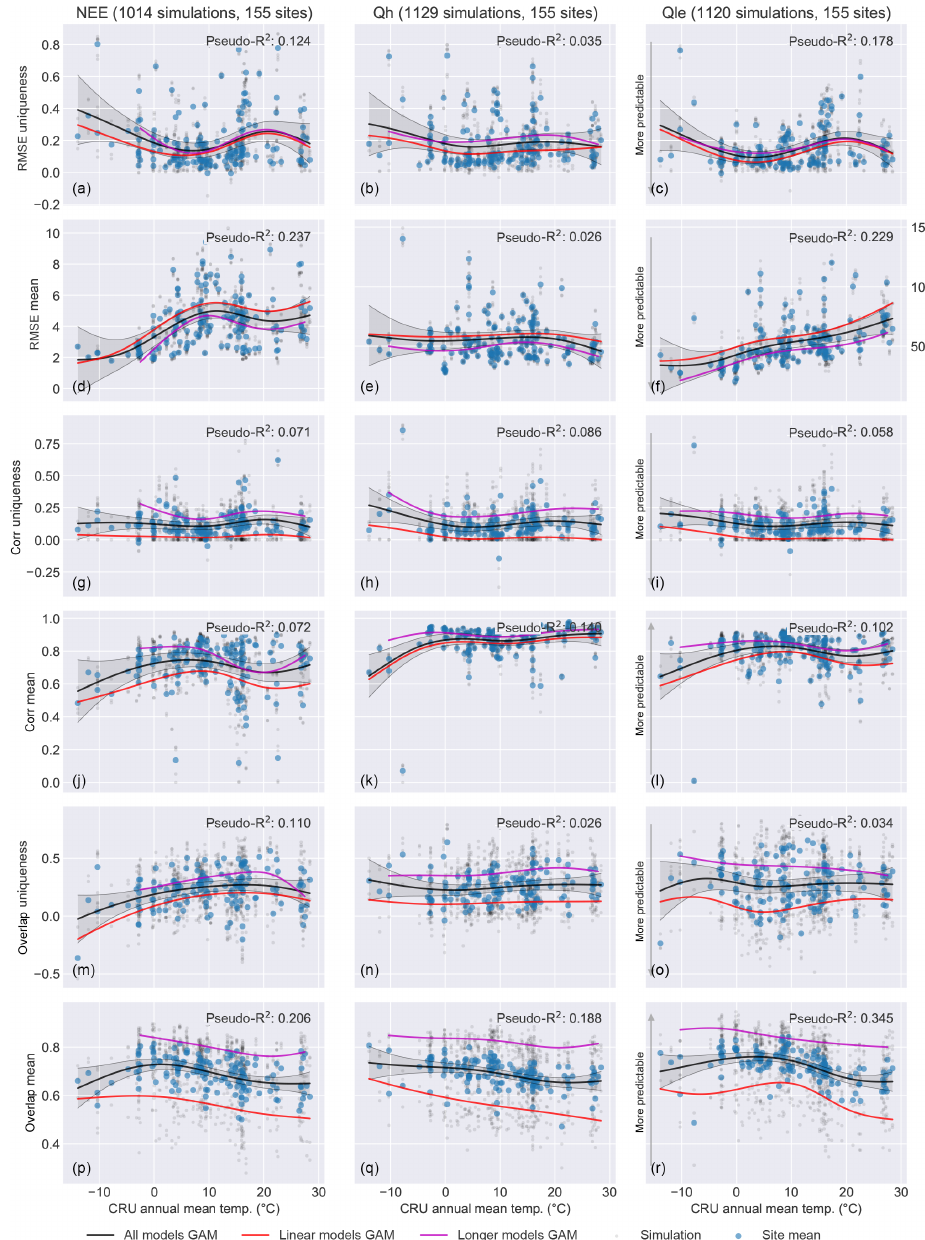
Figure 2. Predictability metrics for mean annual temperature for all models. The three columns represent the three fluxes: NEE, Q h , and Q le . The six rows show RMSE uniqueness, RMSE mean, correlation uniqueness, correlation mean, Overlap uniqueness, and Overlap mean. Grey points are individual simulation values, and blue points are site means across all empirical models. The black line represents a GAM fit of the site means across models, and the ribbon represents a 95% confidence interval. The red line is a GAM fit using only the linear models (S_lin, ST_lin), and the purple line is a GAM fit using only the models with lagged variables (short_term243, long_term243). Note that the mean RMSE for NEE is an order of magnitude smaller than for Q h and Q le , so we have used a different scale for NEE in the second row ( Q h and Q le scale indicated on the